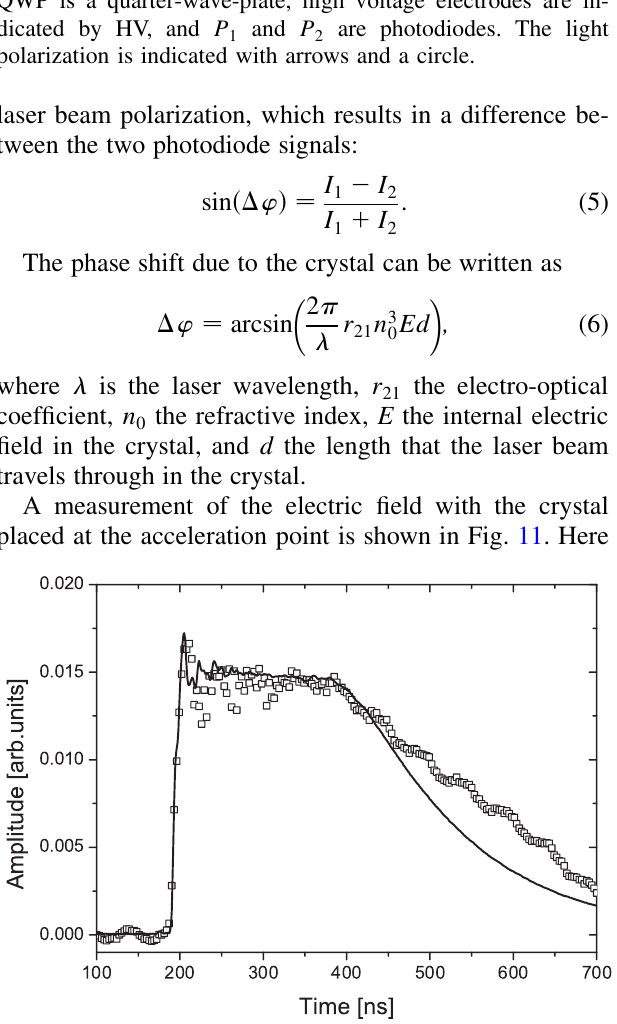
FIG. 11. Electric field measured with electro-optical technique ( (cid:1) ) and output of high voltage source measured with high voltage probe (continuous line) placed on the inner conductor of the